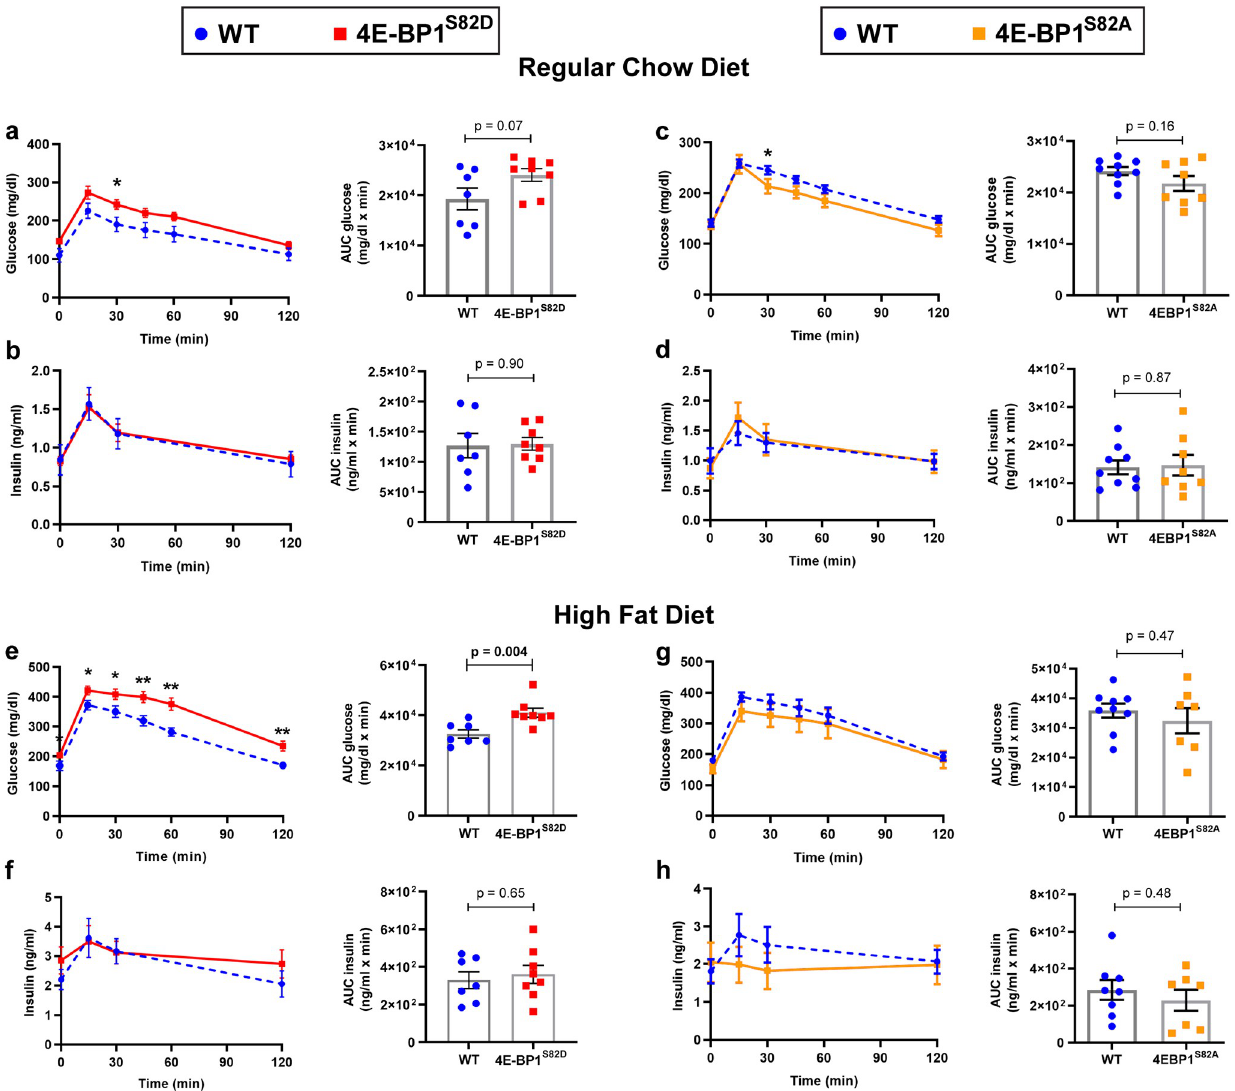
Fig 1. Glucose tolerance tests for male mice fed RCD and HFD showed reduced glucose tolerance for 4E-BP1 S82D mice but not 4E-BP1 S82A mice. 4E-BP1 S82D (n = 8) and WT (n = 7) male littermates were conditioned on RCD, and glucose tolerance tests (GTT) were performed with time course and area under the curve measurements for mouse serum glucose levels (a) and mouse serum insulin levels (b) . 4E-BP1 S82A (n = 8) and WT (n = 9) male littermates on RCD were similarly treated and measured for serum glucose (c) and insulin (d) . After HFD preconditioning for 6 weeks, glucose tolerance tests (GTT) were repeated on these mice with time course and area under the curve measurements for mouse serum glucose levels (e, g) and mouse serum insulin levels (f, h) . Mean and SEM are shown, and each plotted point represents one mouse. Two-tailed t-tests were used to compare groups. Comparisons at each data point were not significant (p � 0.05) unless noted with an asterisk. � p < 0.05, �� p <